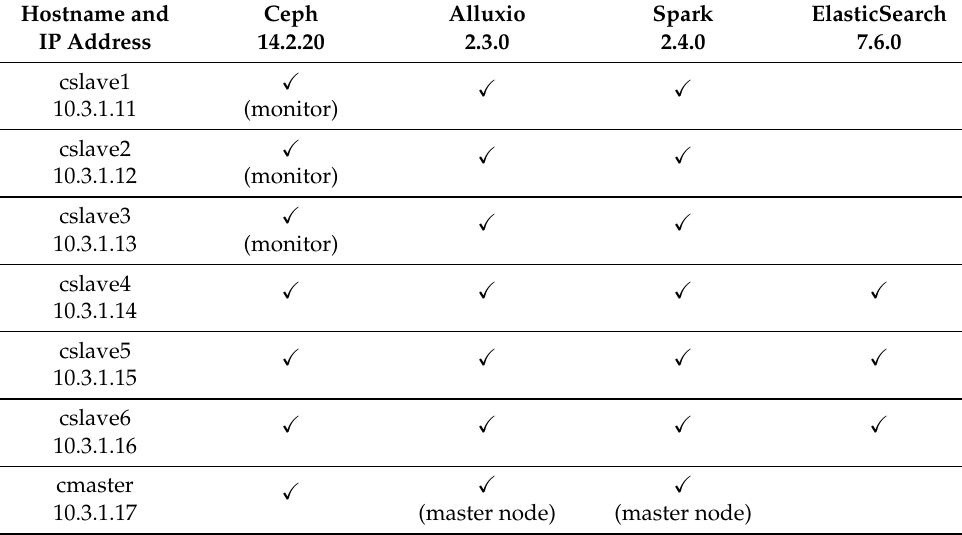
Table 1. Details of software configuration. Note that (cid:88) refers to some components of the software installed in this node.